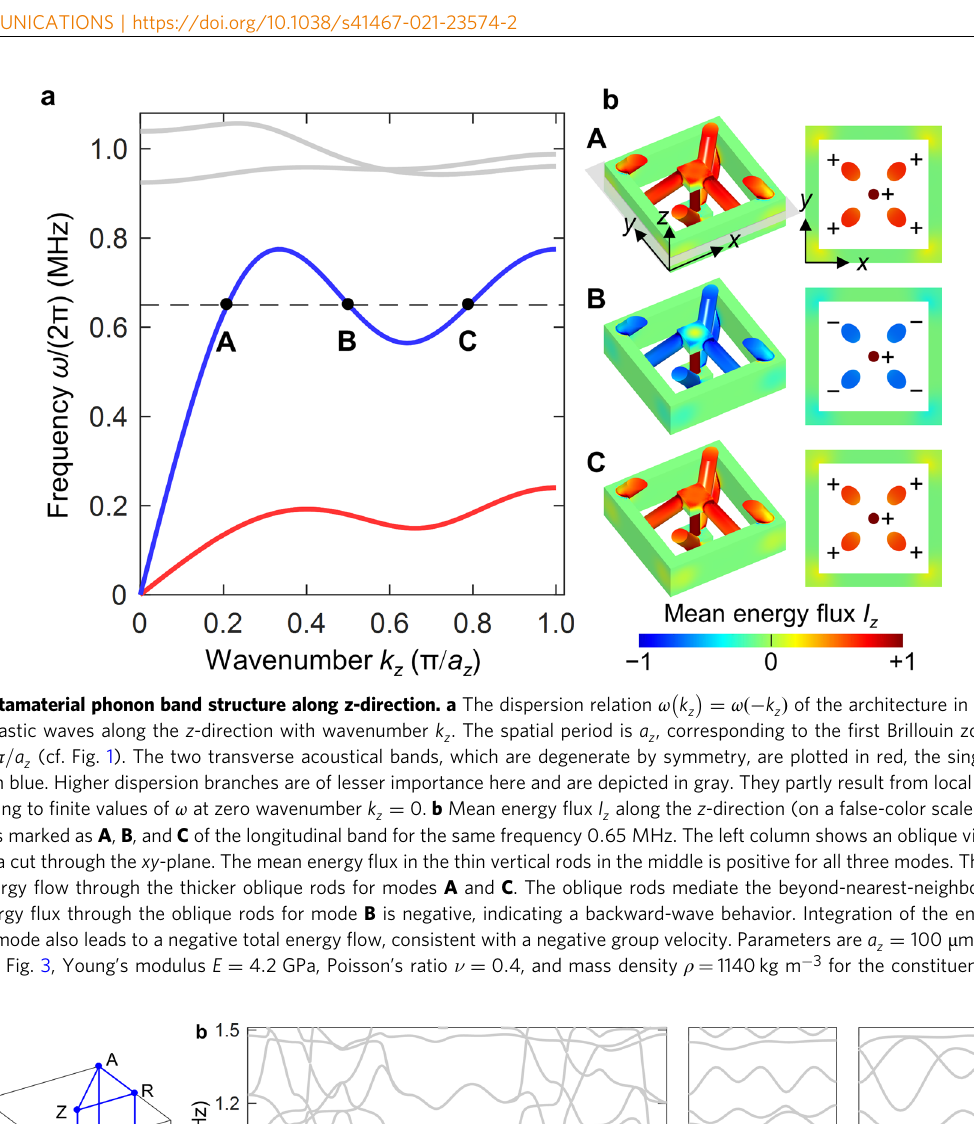
Fig. 5 Elastic metamaterial phonon band structure in 3D. As Fig. 4 (for the metamaterial structure shown in Fig. 3), but for many high-symmetry directions rather than only the Γ Z or z -direction as in Fig. 4. a Illustration of the fi rst Brillouin zone of the tetragonal-symmetry real-space lattice and selected high-symmetric directions in reciprocal space (marked in blue). b Calculated three-dimensional phonon band structure with the characteristic directions as indicated in a . Clearly, due to the used tetragonal symmetry, roton-like acoustical dispersion relations only occur for the Γ Z direction. The corresponding colored bands (blue and red) are the same as the ones shown in Fig.